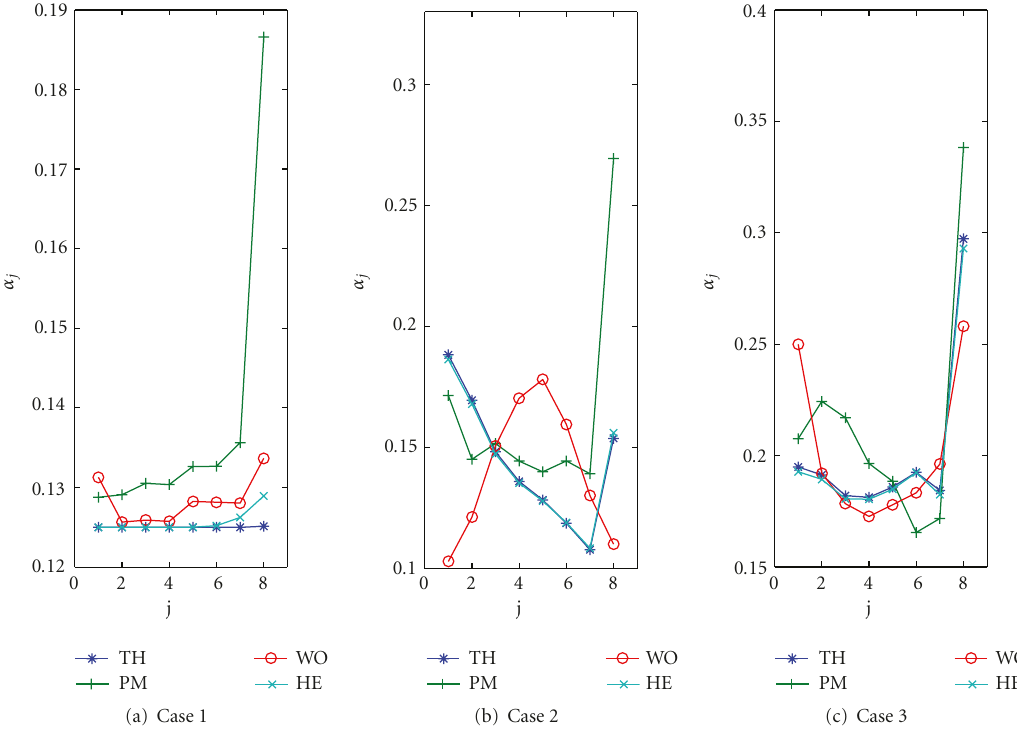
Figure 3: The optimized weighting factors for the bandlimited white noise process when the di ff erent multiple window sets are applied to the di ff erent cases, Thomson windows (stars), Peak Matched multiple windows (pluses), Welch method (circles), Hermite functions